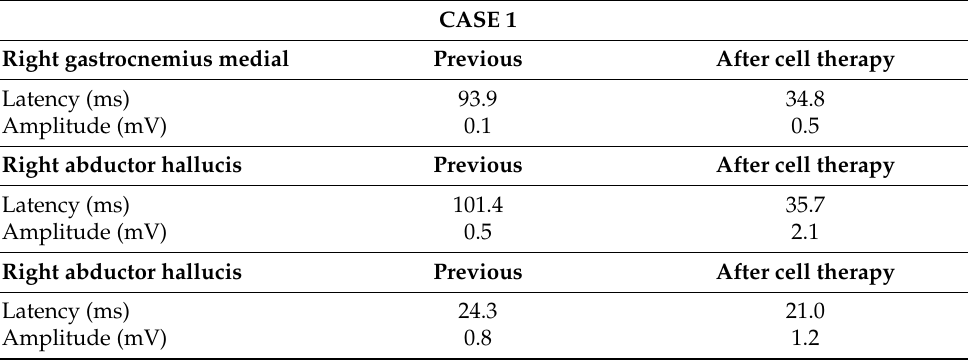
Table 1. Mean values of the motor responses obtained after transcranial magnetic stimulation. After cell therapy, improvements in latency and amplitude in motor evoked potentials were observed.